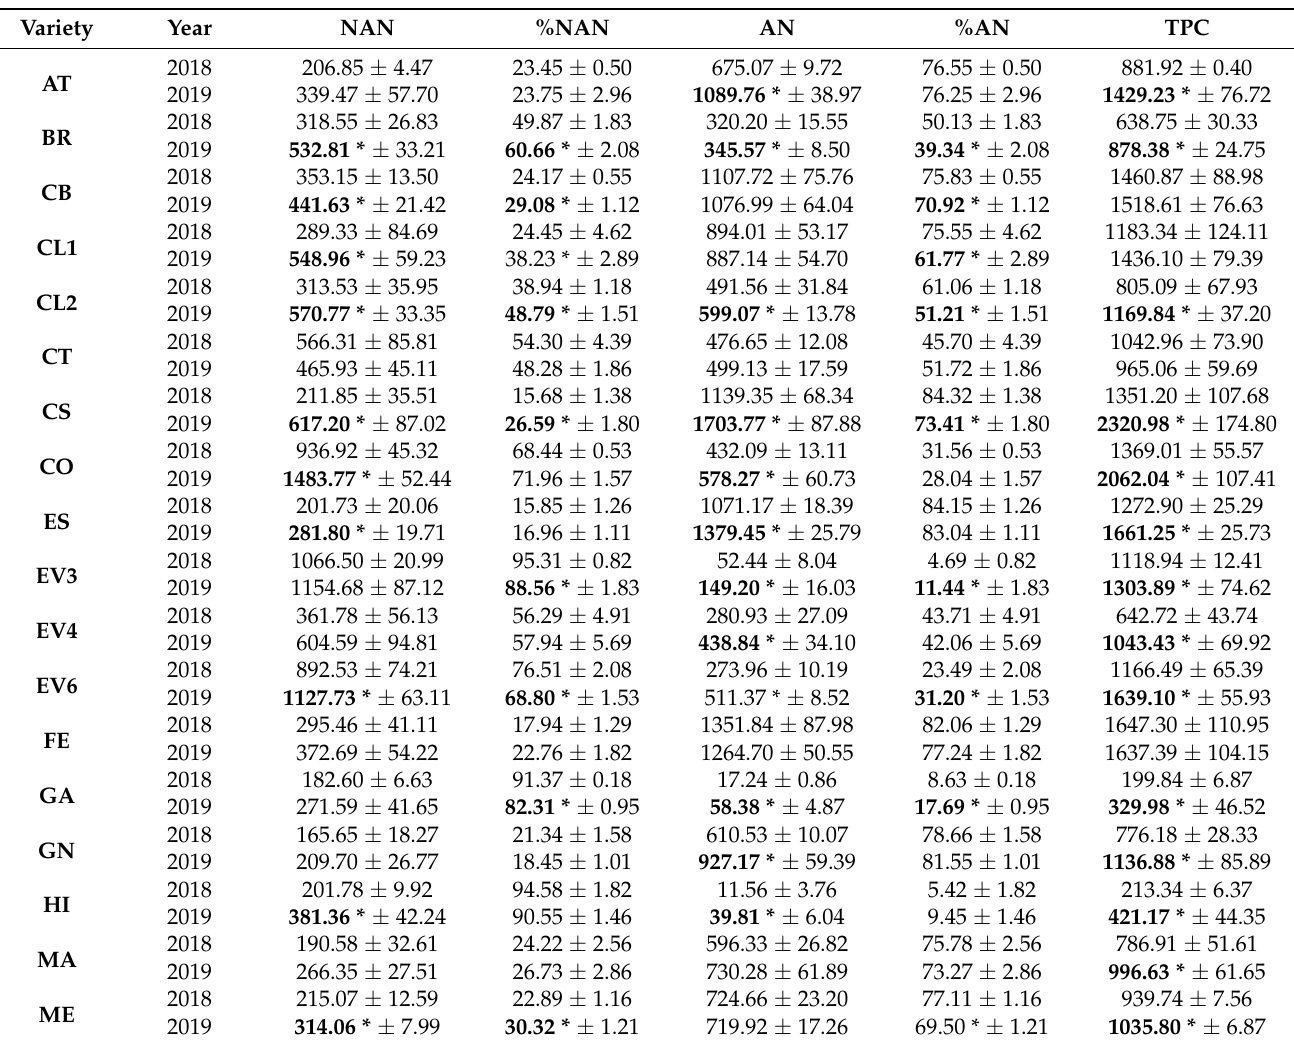
Table 2. Non-anthocyanin, anthocyanin, and total polyphenolic content. (Values for phenolic compounds of varieties from the EVEGA germplasm bank in 2018 and 2019 vintages are expressed as mg · kg − 1 fresh berry weight (FW) for NAN, AN and TPC values and percentages of non-anthocyanin and anthocyanin were used in % NAN and % AN,